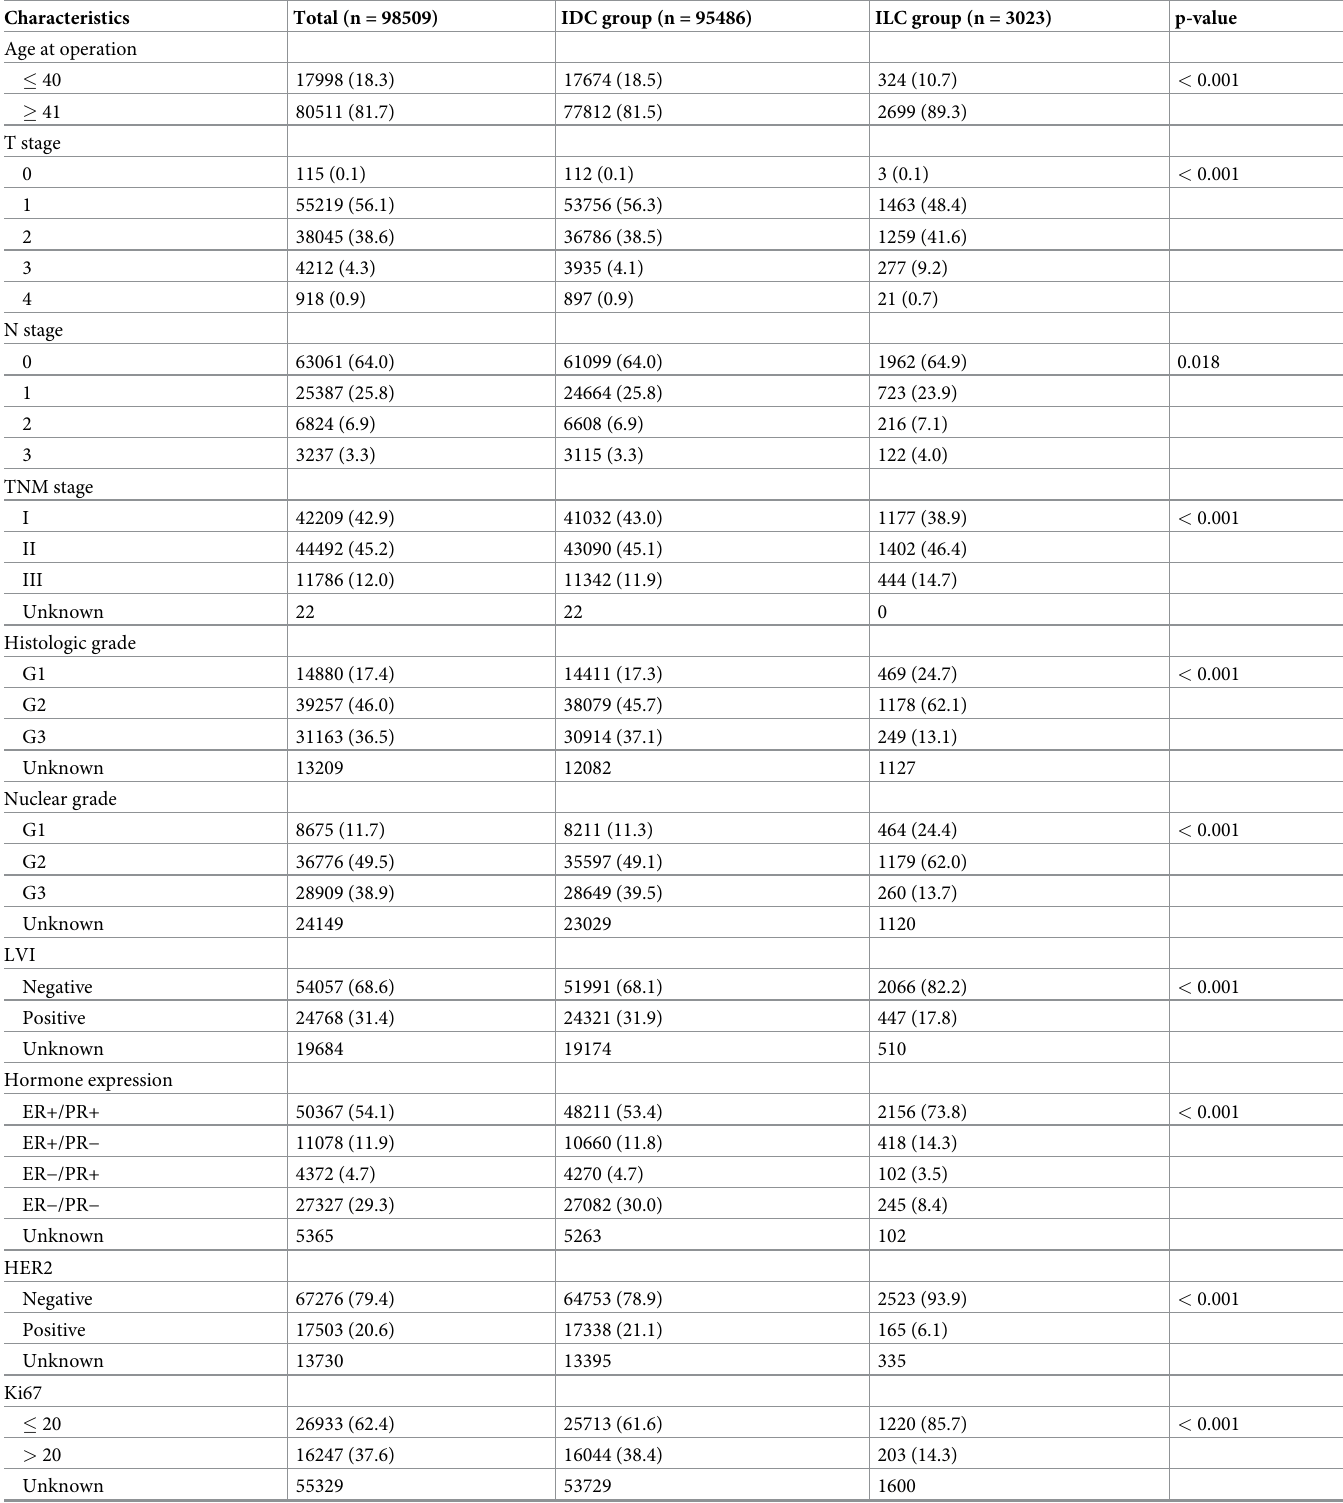
Table 1. Clinicopathological characteristics of patients with invasive breast